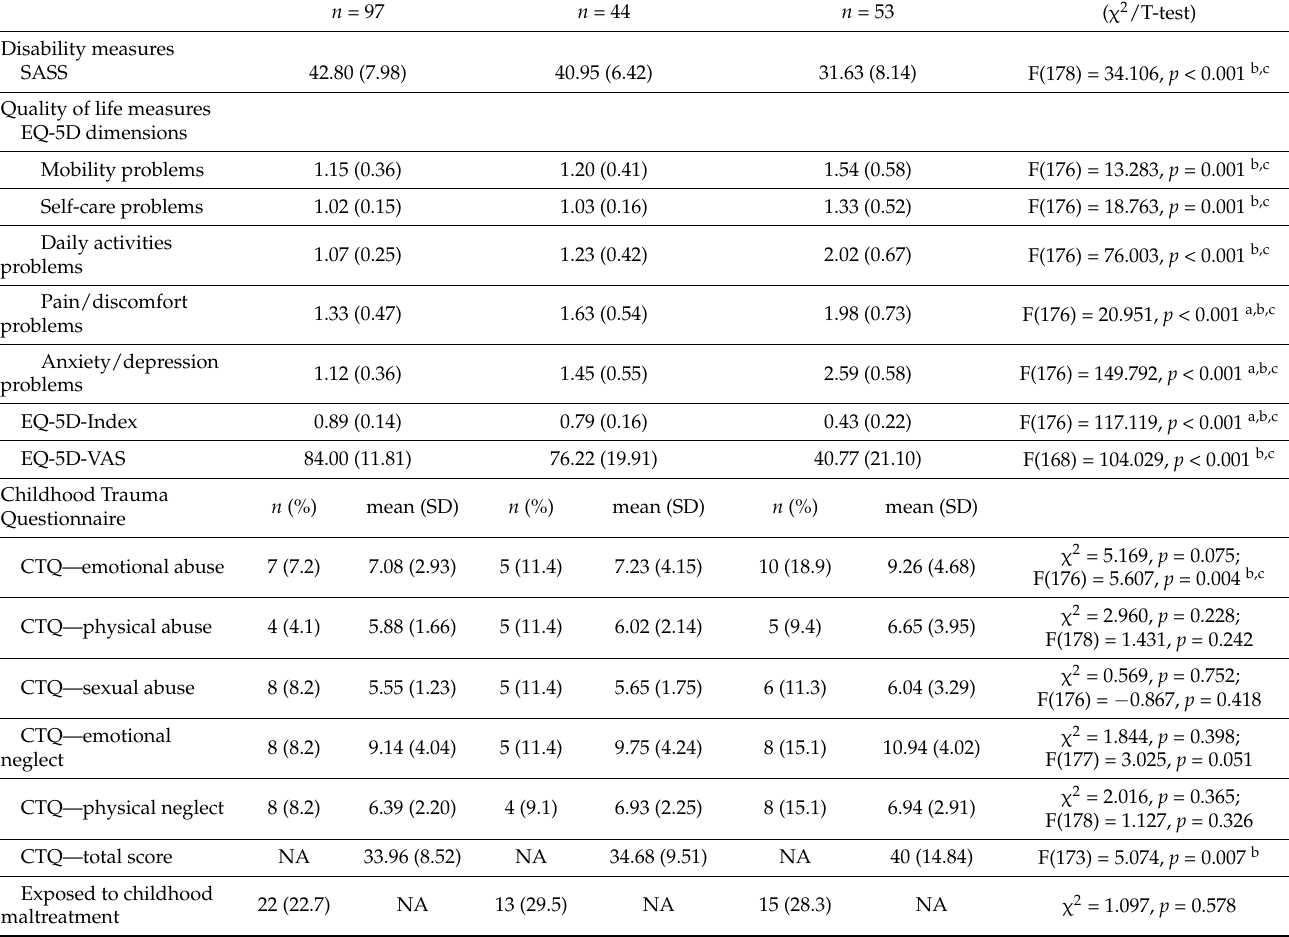
Table 1 contains information on functionality, QoL, and CM variables. Patients with non-remitted MDD reported poorer functionality and lower QoL in all EQ-5D dimensions, the EQ-5D-index and the EQ-5D-VAS than HCs or remitted MDD patients. Remitted MDD patients reported more severe pain/discomfort and anxiety/depression problems and